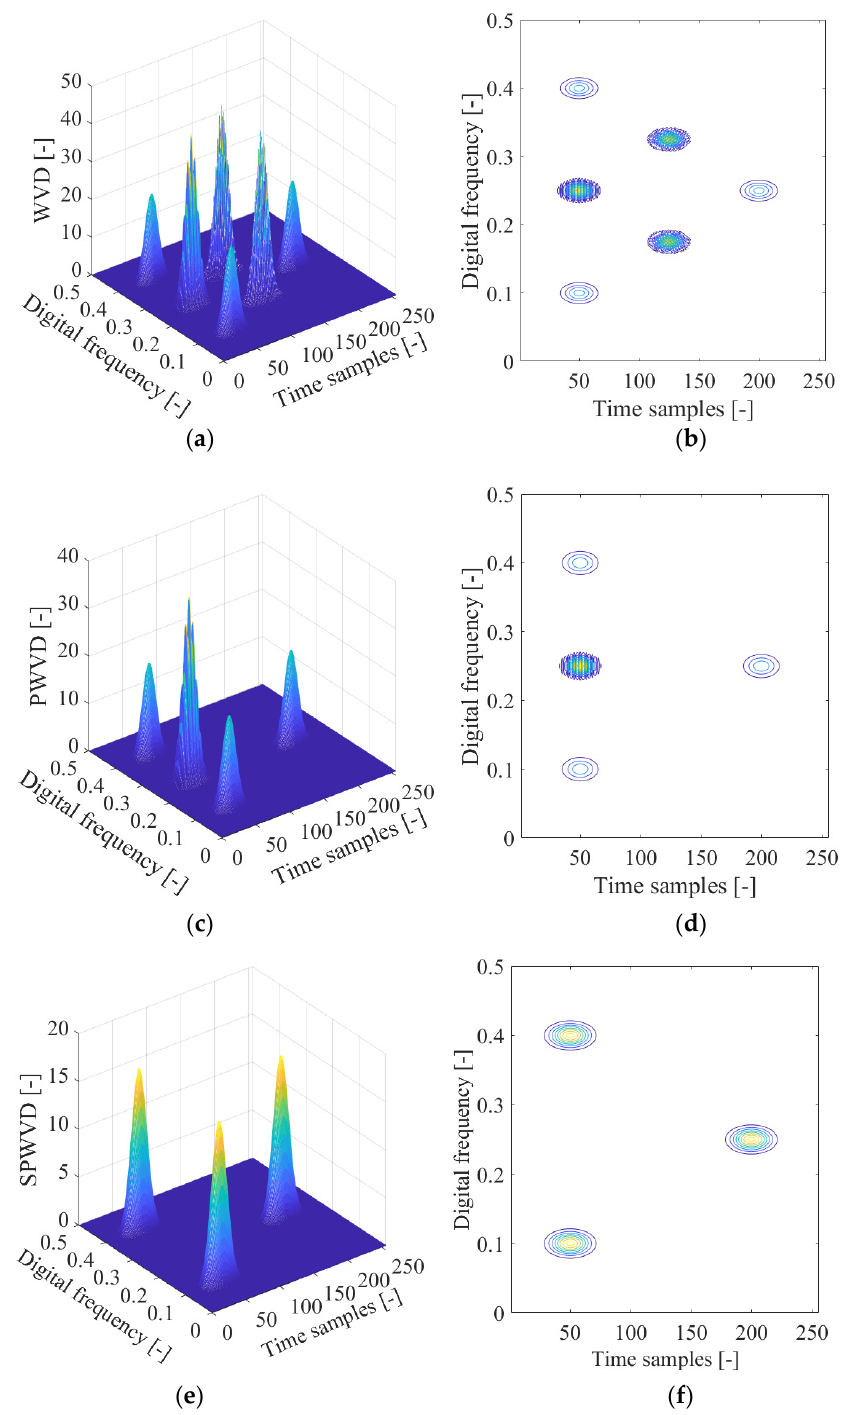
Figure 4. The time-frequency distributions of a nonstationary signal composed of three transient Gaussian components. ( a ) Wigner–Ville distribution (WVD); ( b ) WVD’s contour; ( c ) Pseudo-Wigner–Ville distribution (PWVD); ( d ) PWVD’s contour; ( e ) Smoothed pseudo-Wigner–Ville distribution (SPWVD); ( f ) SPWVD’s contour.